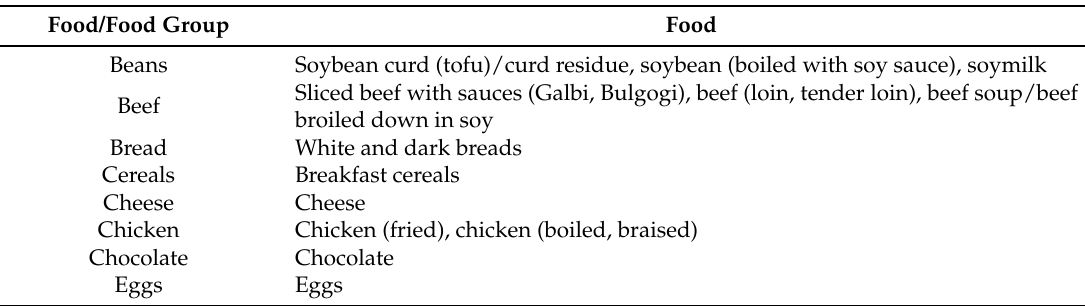
Table 1. Thirty ‐ three food groups used in statistical analyses with factor analysis. Table 1. Thirty-three food groups used in statistical analyses with factor